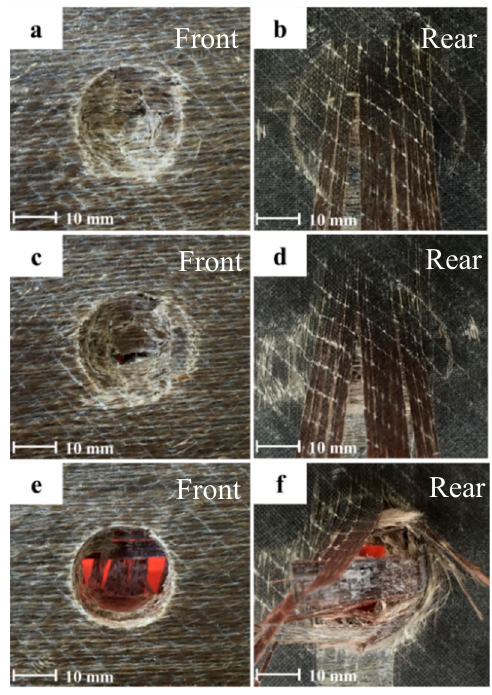
Figure 3. Images of damage progression on the front and rear faces of a flax / VE / basalt hybrid composite where basalt was placed on the rear side of the composite panels impacted in the range of ( a , b ) 50 J, ( c , d ) 60 J, and ( e , f ) 70 J.